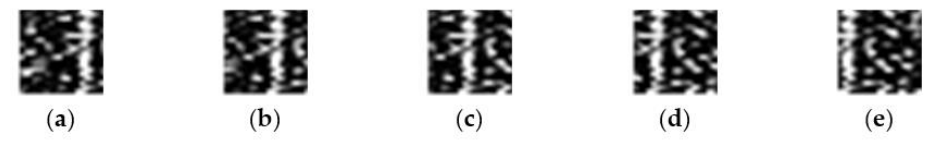
Figure 11. Partial 20 × 20 sample graph with target under the condition of 0 dB SNR, and the target in unit positions are ( a ) 0.8, ( b ) 0.65, ( c ) 0.5, ( d ) 0.3, and ( e ) 0.15.